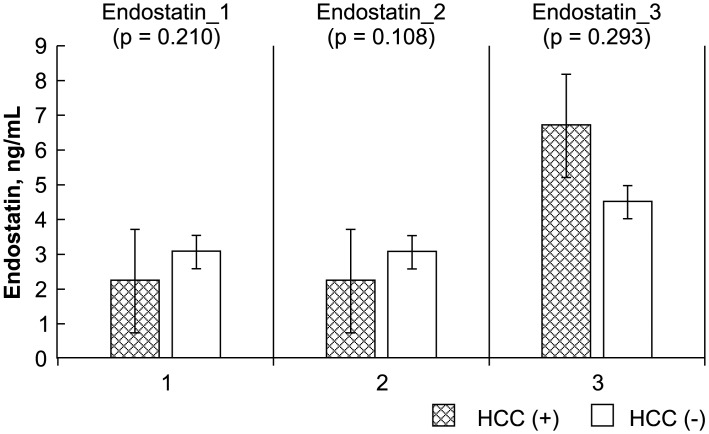
Statistical analysis of FGF-2, survivin, Ki67, endostatin, and VEGF levels, as measured by ELISA before (_1), early after (_2), and late after (_3) after living donor liver transplantation (LDLT).The Mann-Whitney U test was used to compare the differences in the biomarkers at the various time points between the recipients with and those without HCC recurrence.